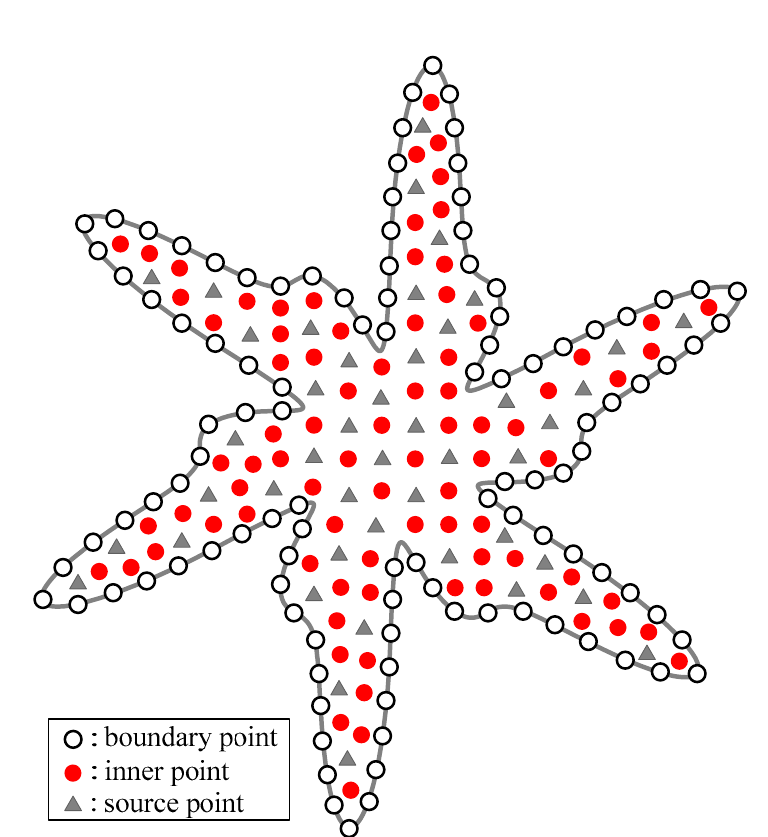
Figure 1. Layout of boundary, source and inner points for example 3.1.